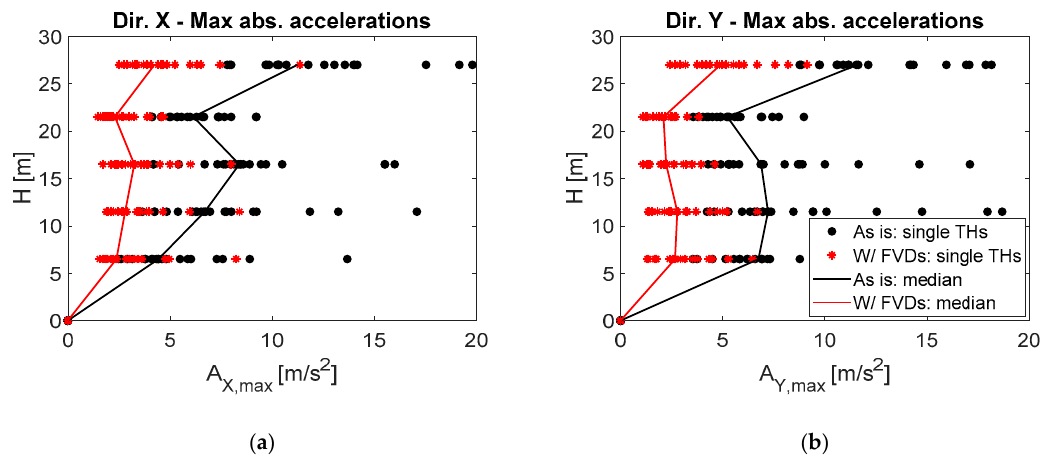
Figure 23. Maximum absolute accelerations along the height of the tower, before and after retrofitting: ( a ) X direction; and ( b ) Y direction.